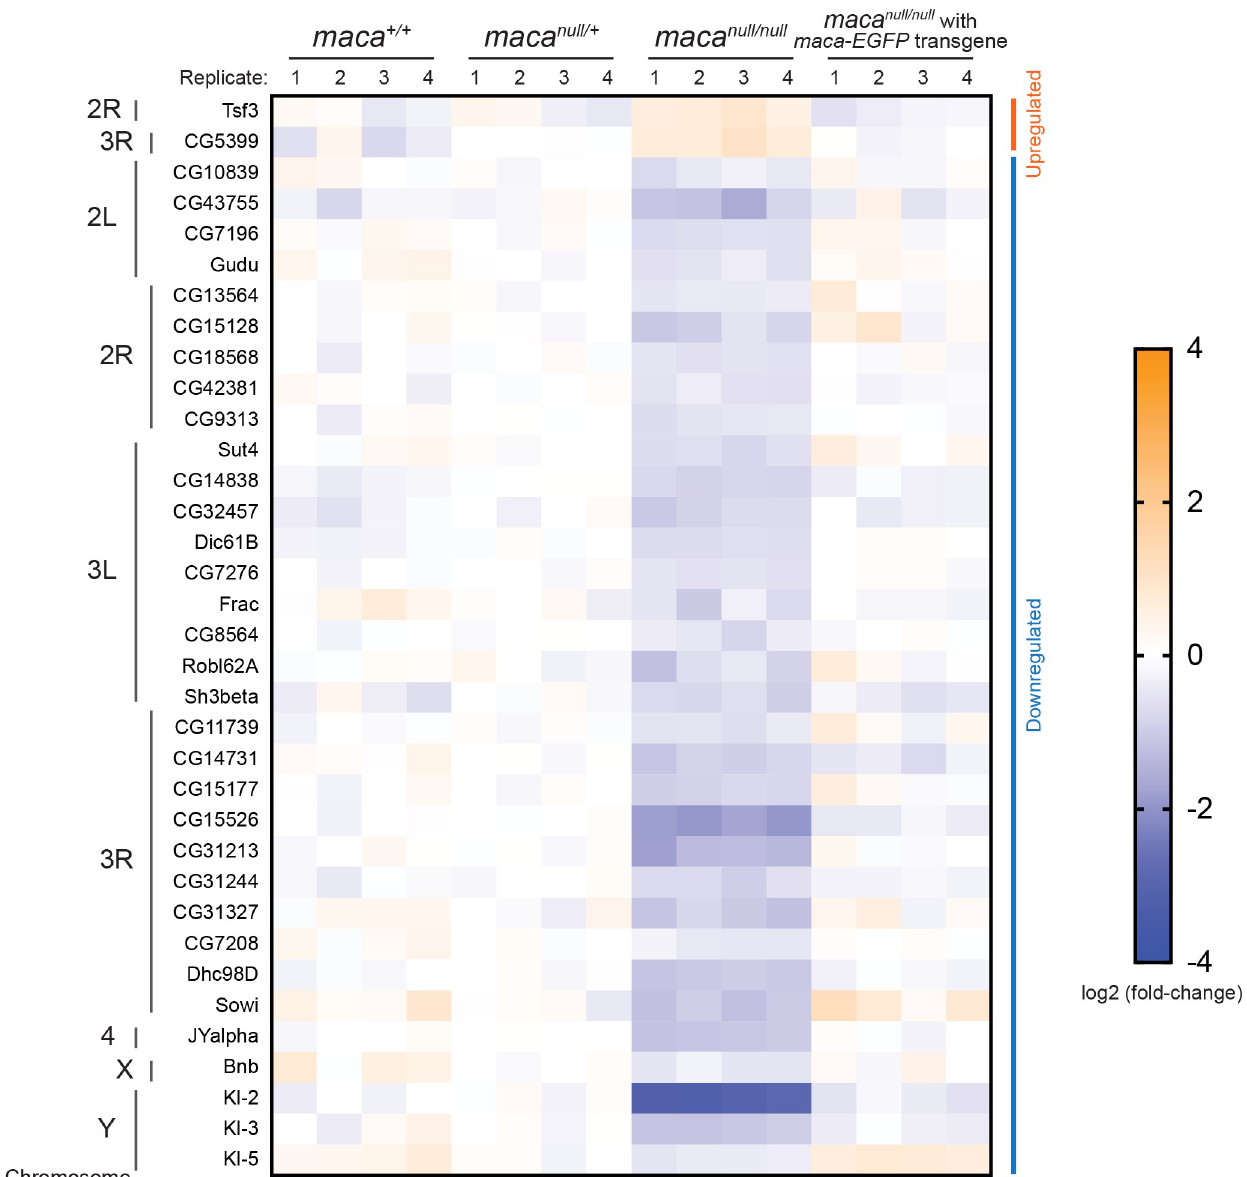
Fig 3. Proteins dysregulated in maca null/null testes including downregulated Kl-2, Kl-3, and Kl-5 revealed by mass spec. Heatmap of protein levels that were significantly dysregulated in the maca null/null testes compared with the testes from maca +/+ , maca null/+ , and maca null/null with maca-EGFP rescue transgene determined by mass spec with TMT labeling. Log 2 (fold-change compared with the means of maca null/+ ) are shown. Four biological replicates for each genotype. Two proteins (at the top) were significantly upregulated (relative abundance > 1.3, adjusted P-value < 0.05) and 33 proteins were significantly downregulated (relative abundance < 0.77, adjusted P-value < 0.05) in maca null/null compared with all the other three genotypes. Male fertility factor Kl-2 was most strongly and significantly downregulated (relative abundance 0.12 and adjusted P-value 1.7 x 10 − 5 in maca null/null compared with maca null/+ ). Proteins are sorted based on the chromosomal positions of the corresponding